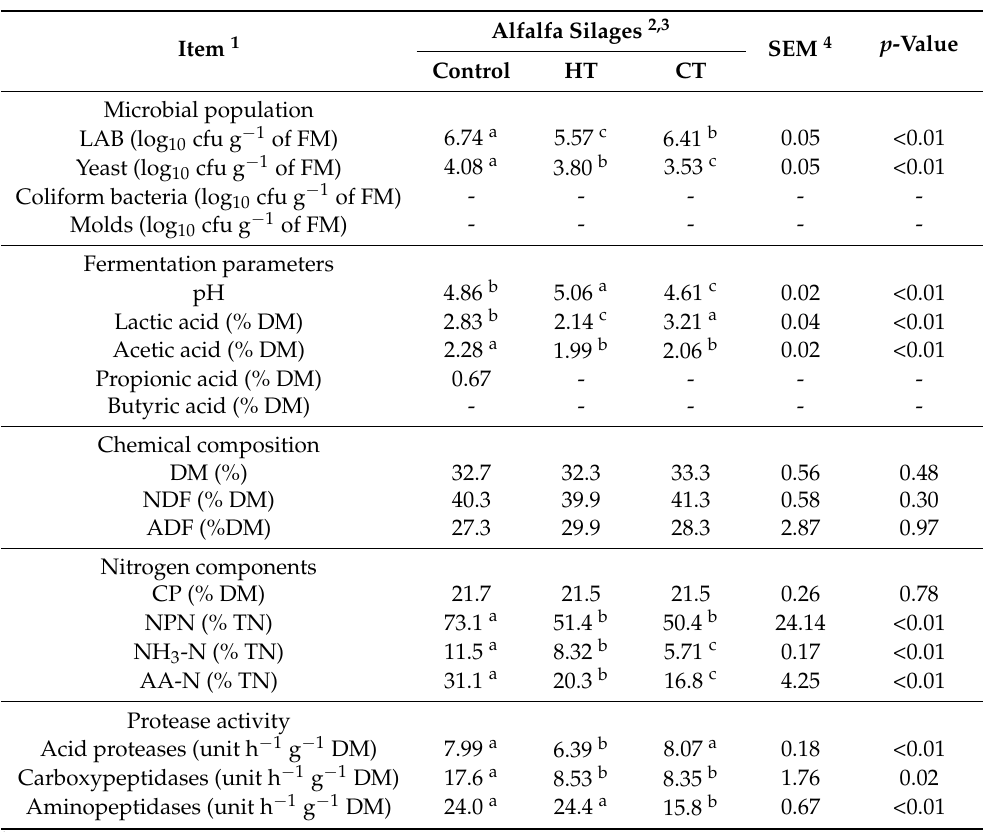
Table 3. Microbial population, fermentation parameters, chemical composition, nitrogen components, and protease activity of alfalfa